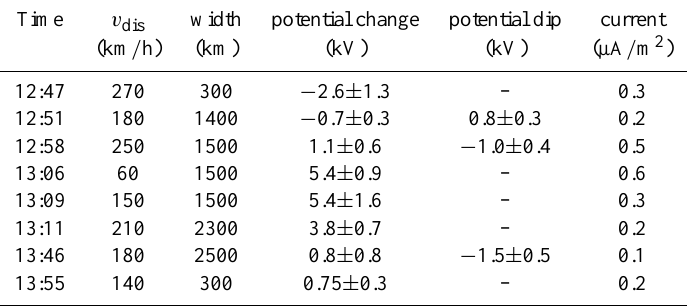
Table 1. Summary of parameters of the observed separatrix regions on 4 January 2004. The table shows (1) the time of the event, (2) the velocity of the discontinuity, (3) the width of the separatrix region, (4) the potential change over the separatrix region with the starting point on the magnetospheric side of the separatrix region, (5) the potential dip with respect to the magnetospheric level and positive sign corresponds to diverging electric fields and (6) the magnitude of the parallel current. The potential dip is a potential change over a region smaller than the width of the separatrix region. Time v dis width potential change potential dip current (km / h) (km) (kV) (kV) (µA / m 2